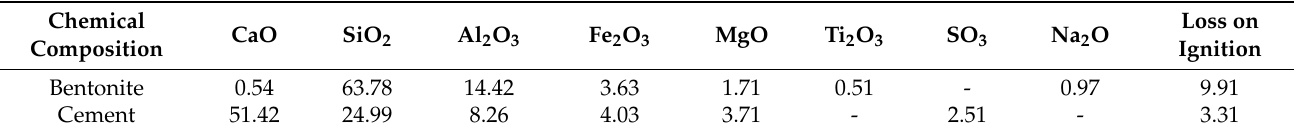
Table 1. The major chemical composition of bentonite and cement as wt%.